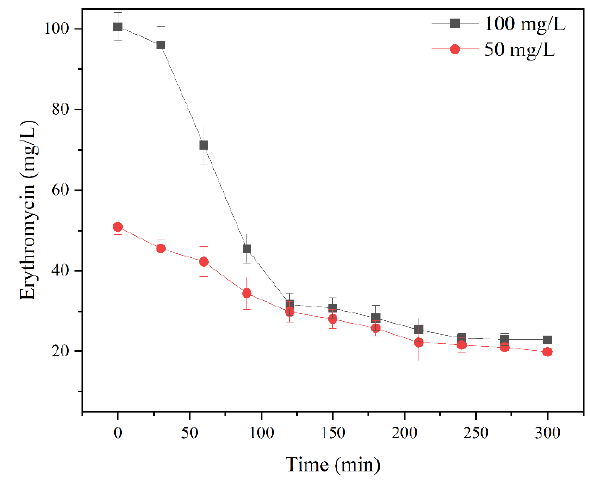
Figure 7. Degradation performance of EreB@modified palygorskite in erythromycin-polluted wastewater containing 50 and 100 mg·L – 1 erythromycin.